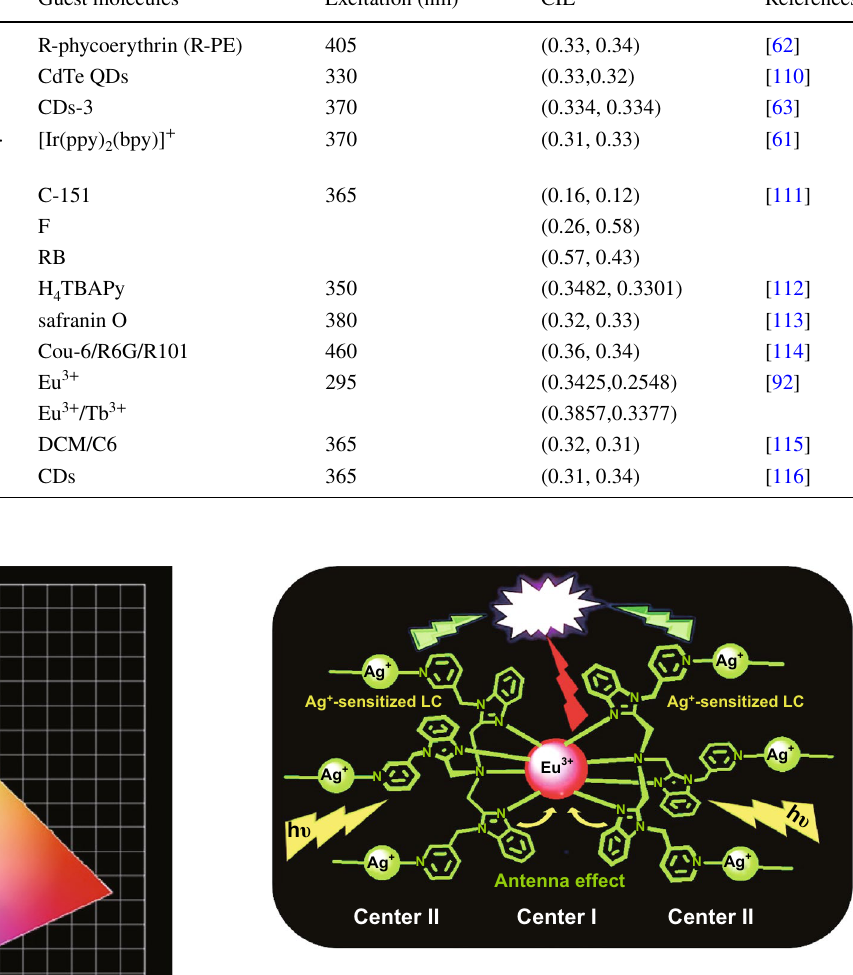
Fig. 24 Dual-emitting pathways in the Ag-doped MOF generating white-light emission. Reprinted with permission from Ref. [64].